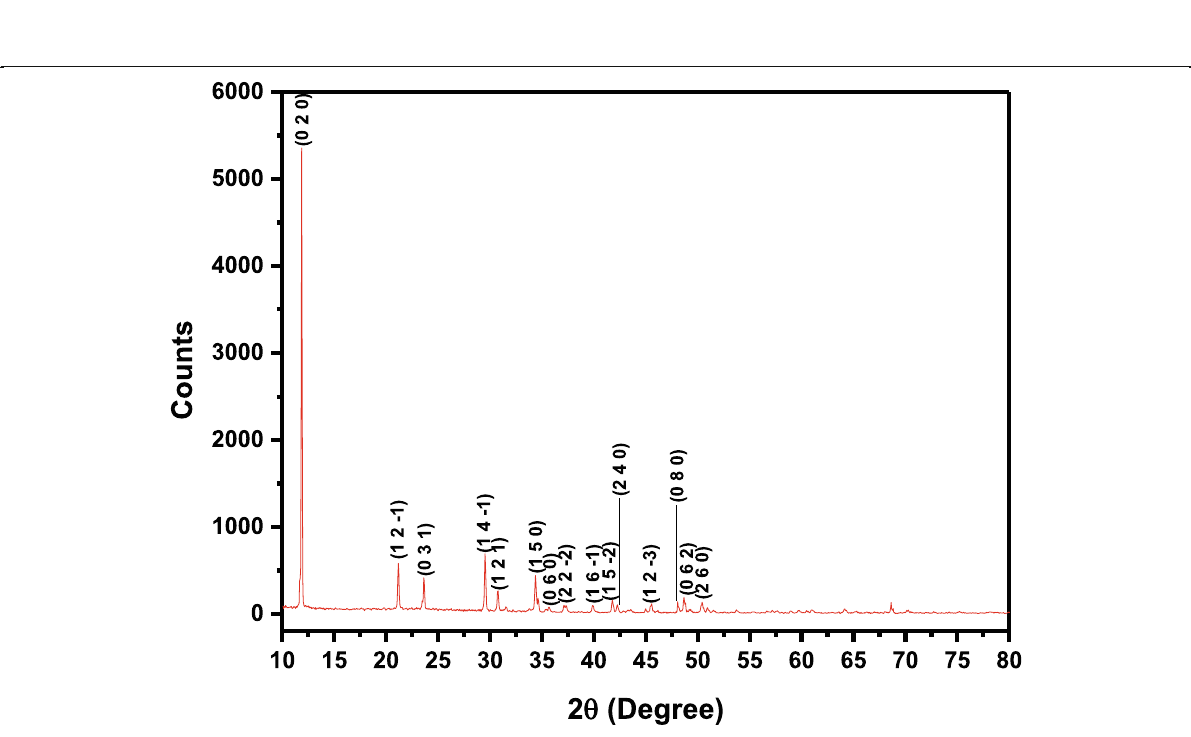
Fig. 6 Powder XRD spectrum of 50 mg A. marmelos added CHPD